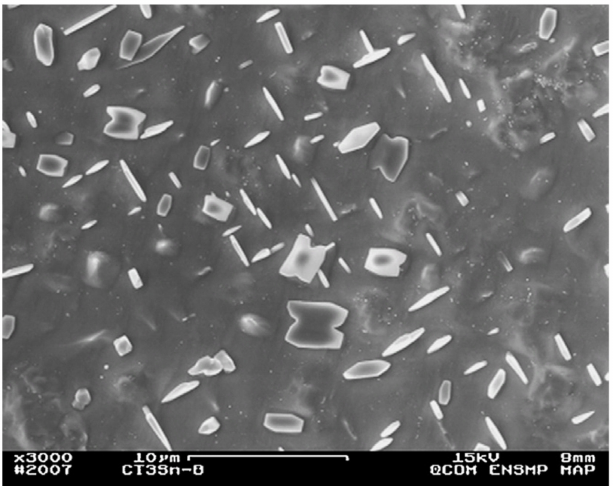
Figure 26. Observation under SEM, proving the presence of fine precipitates in the core of den- drites